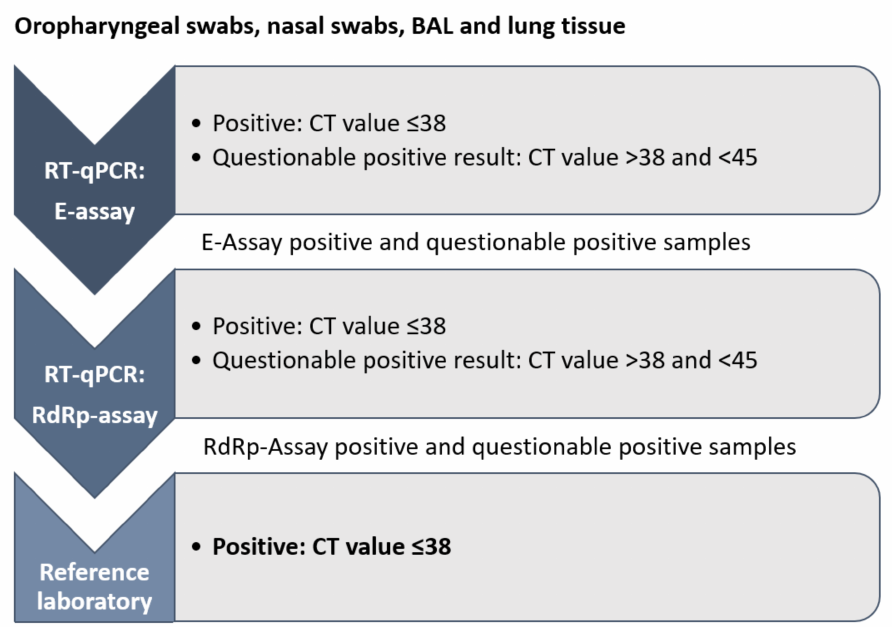
Figure 1. Workflow of molecular analysis applied. The extracted nucleic acids from all oropharyngeal swab samples ( n = 1132), nasal swabs samples ( n = 1125), bronchioalveolar lavage ( n = 2), and lung tissue samples ( n = 2) were run in the reverse transcriptase real-time polymerase chain reaction (RT- qPCR) targeting the viral envelope (E) gene. Positive and questionable positive samples were further analyzed by RT-qPCR targeting the RNA dependent RNA polymerase (RdRp) gene. If